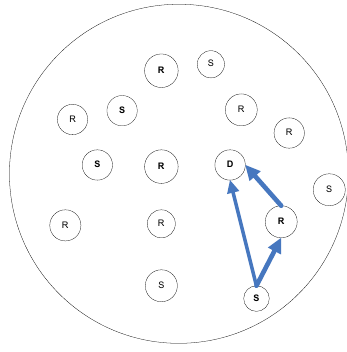
Figure 5. System model of the wireless network (from work in